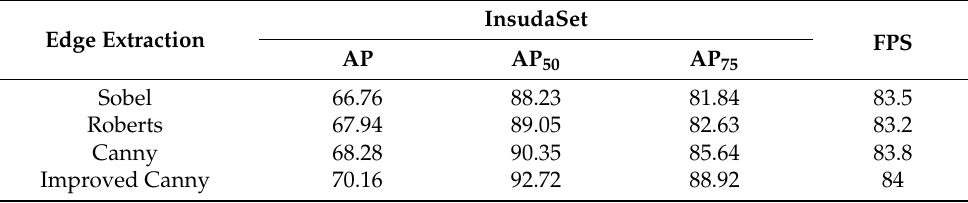
Table 6. Comparison accuracy and speed table of different edge extraction methods. Edge